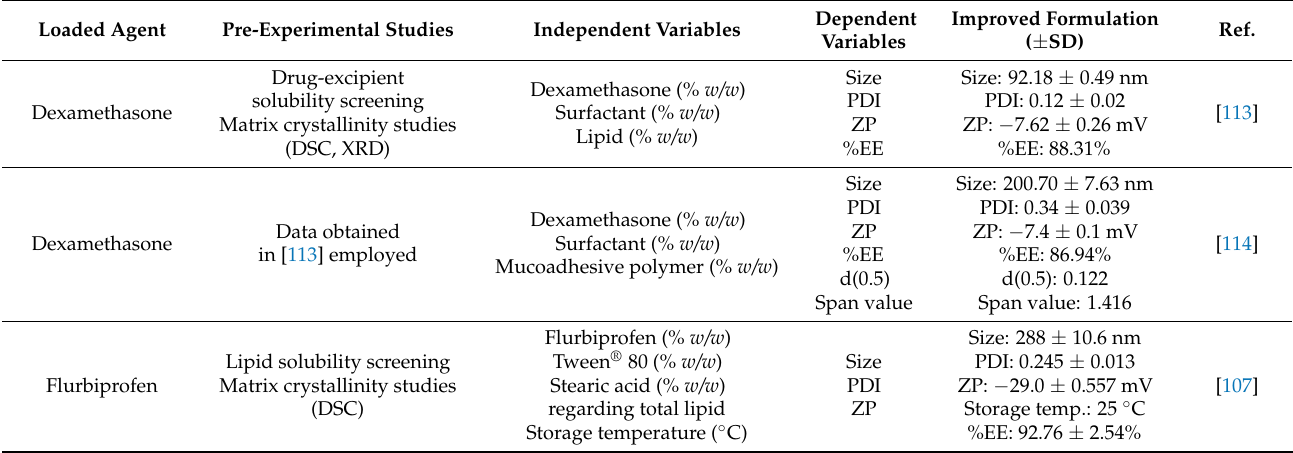
Table 1. Examples of the application of two-level (2k) full factorial designs in lipid-based nanocarrier production. Loaded